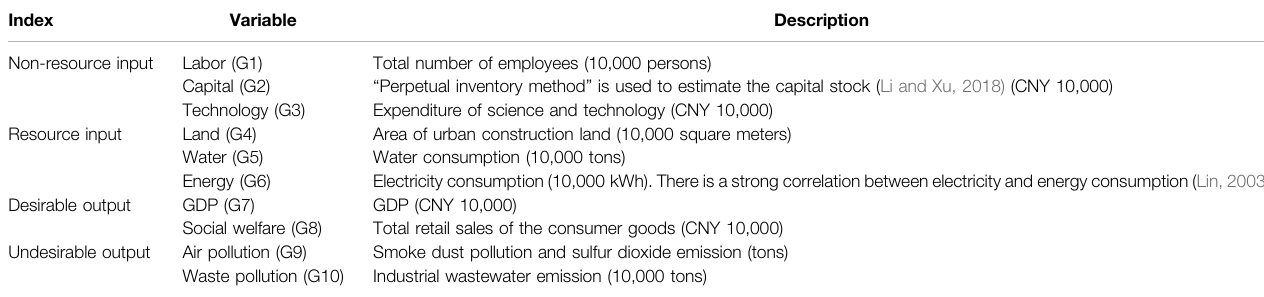
TABLE 1 | Input – output indicators and description of the green economic ef fi ciency. Index Variable Description Non-resource